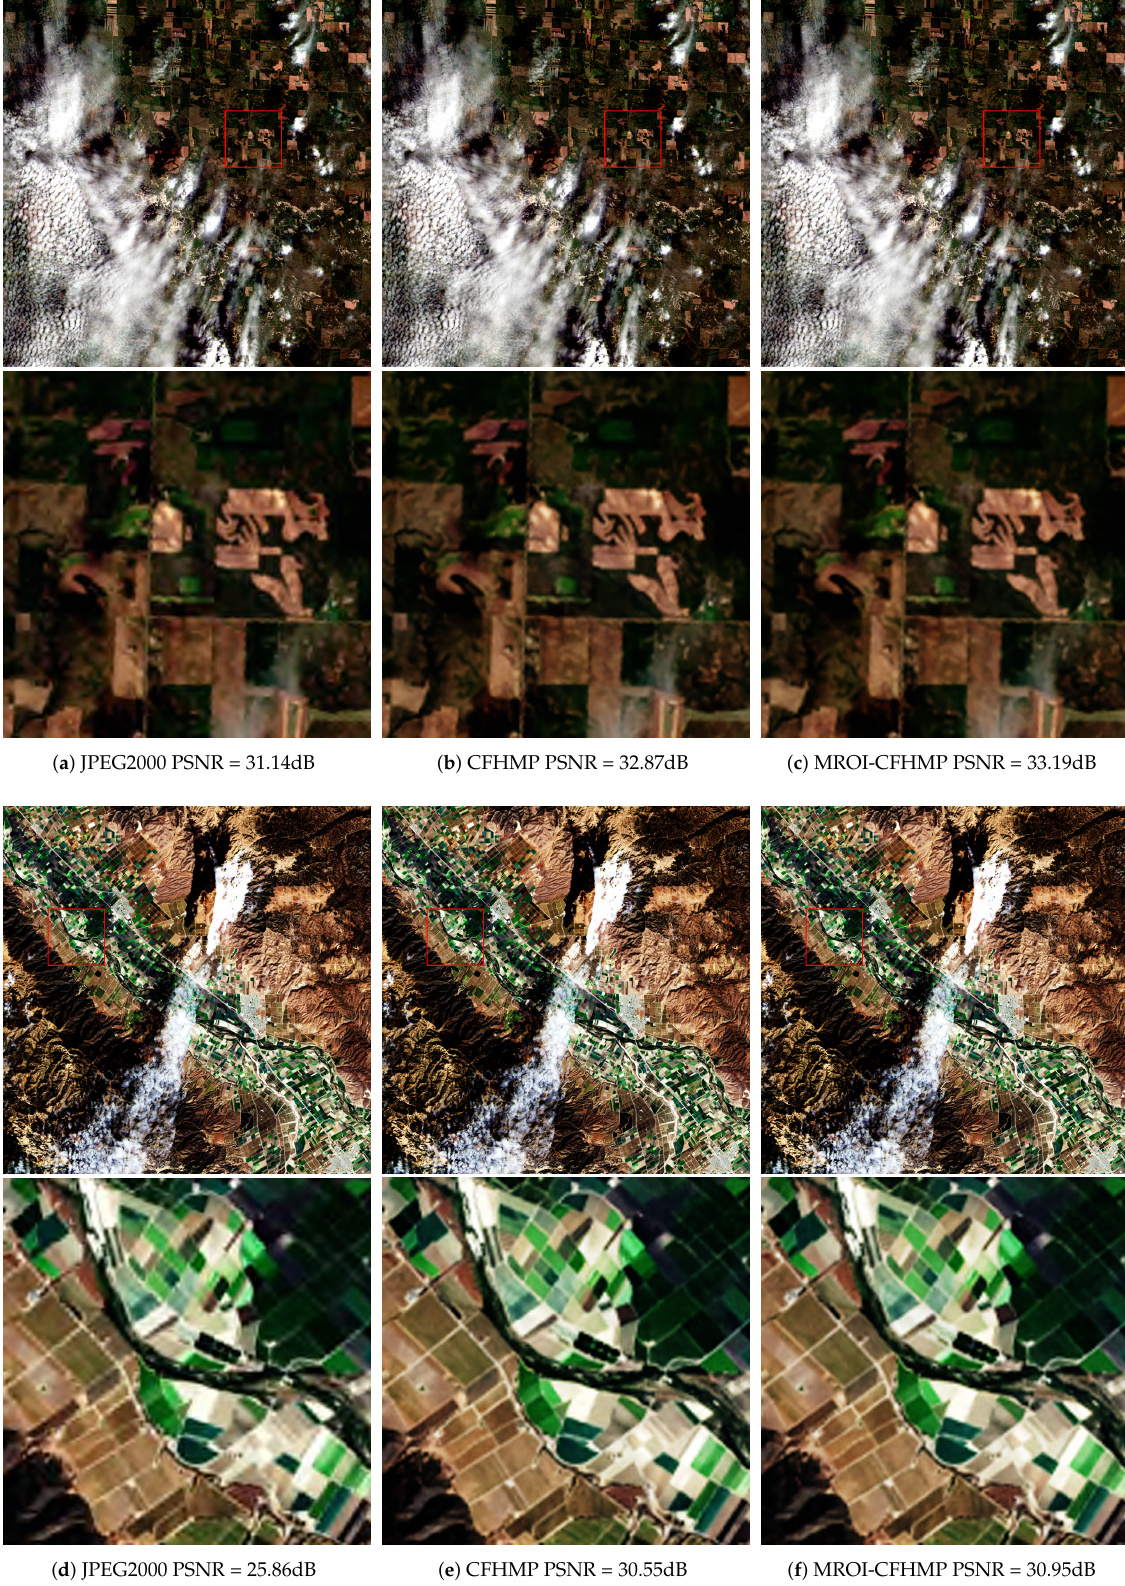
Figure 8. Comparison of Subjective Performance of Different Compression Algorithms on the Landsat Image Test Set with bpp =